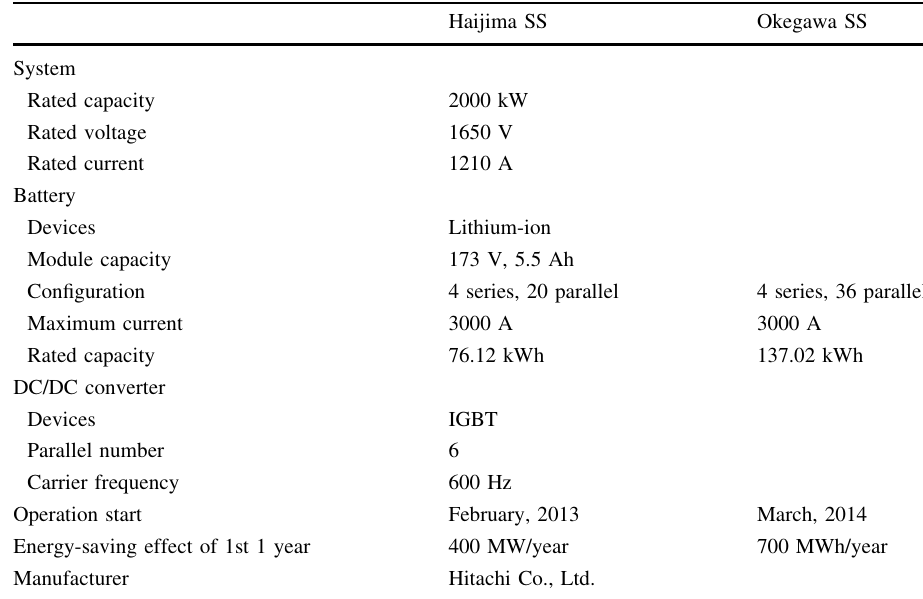
Table 1 Specifications of energy storage system installed at Haijima SS and Okegawa SS